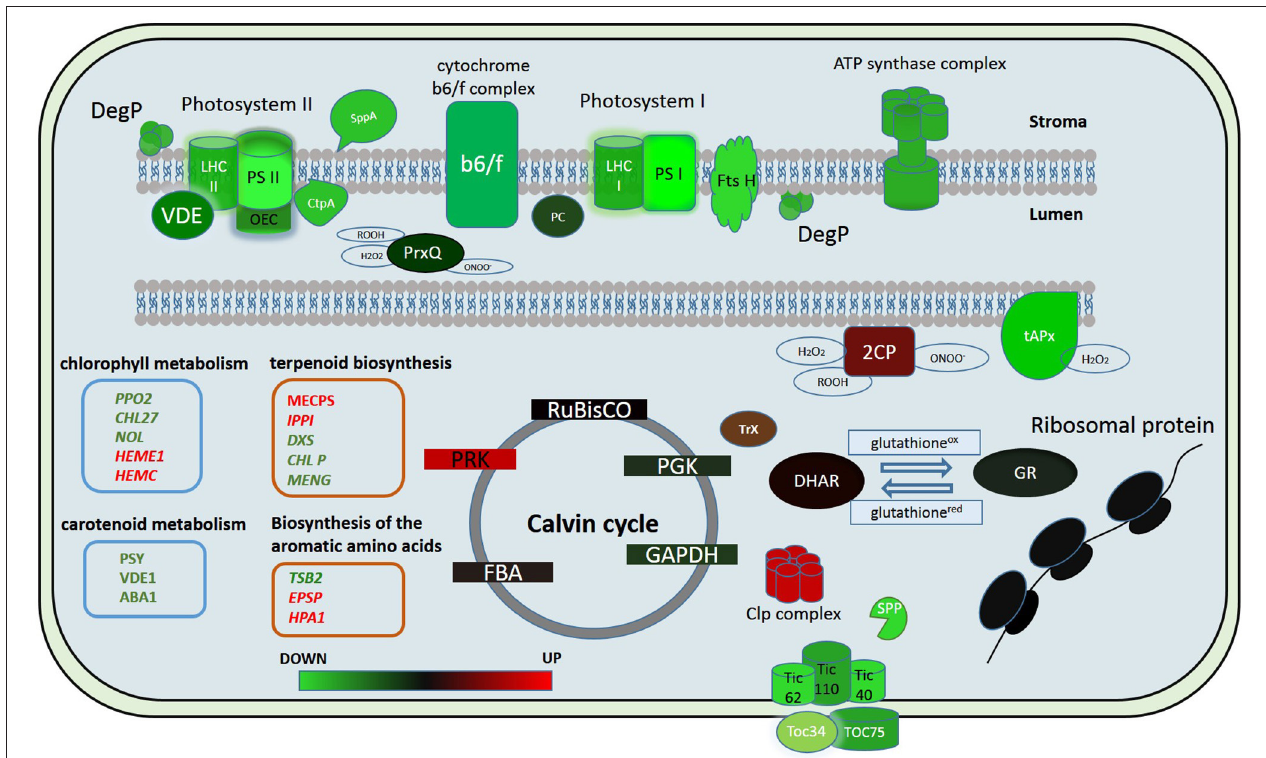
FIGURE 5 | Putative model of the chloroplast proteome changes in response to short-term complex stress in P. patens . The color code is as follows: green indicates down-regulated proteins, red indicates up-regulated proteins. PSI, Photosystem I; PSII, photosystem II; LHC I, light-harvesting complex photosystem I; LHC II, light-harvesting complex photosystem II; OEC, oxygen-evolving complex; PC, plasocyanin; VDE, violaxanthin deepoxidase; Ctp A, Carboxyl-terminal Processing Protease; Prx Q, Peroxiredoxin Q; 2CP, 2-cys-peroxiredoxin; tAPx, thylakoid ascorbate peroxidase tAPX; Trx, thioredoxin; DHAR, dehydroascorbate reductase; GR, glutathione reductase; RuBisCO, Ribulose-1,5-bisphosphate carboxylase/oxygenase; PRK, phosphoribulokinase; PGK, phosphoglycerate kinase; GAPDH, glyceraldehyde-3-phosphate dehydrogenase; FBA, fructose-bisphosphate aldolase; Toc 75, component of the translocon outer membrane (TOC) complex; Toc 34, component of the translocon outer membrane (TOC) complex; TIC40, translocon at the inner envelope membrane of chloroplasts; TIC110, translocon at the inner envelope membrane of chloroplasts; TIC62, translocon at the inner envelope membrane of chloroplasts; SPP, signal peptide peptidase; Clp complex, ATP-dependent Clp protease proteolytic